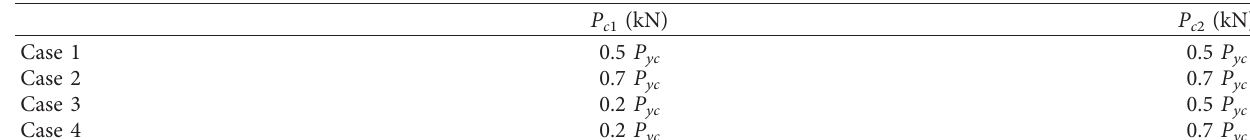
Figure 12: Static nonlinear analysis of three models. Note. P yb is the yield axial force of the beam. Table 7: The cases of different column pressures.